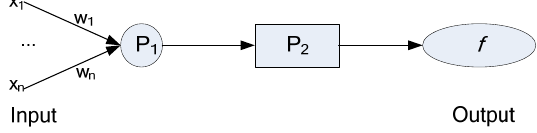
Fig.1. The structure and function of artificial